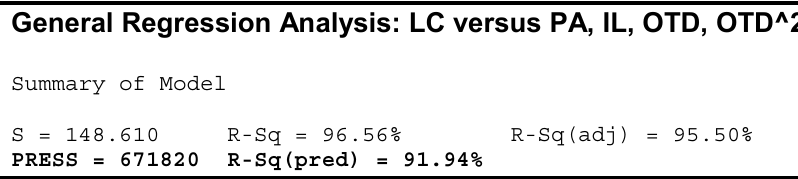
Figure 7. Subsets Regression.